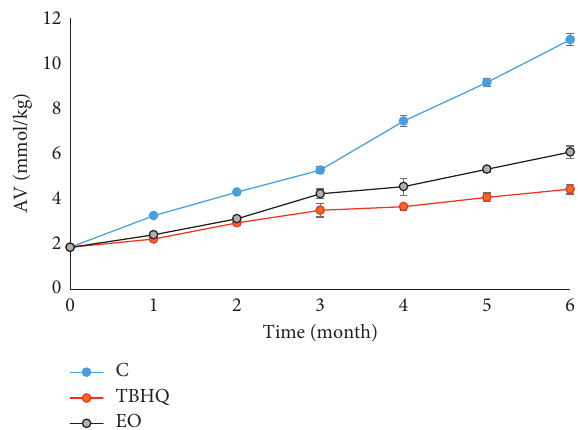
Figure 2: The thiobarbituric acid index (mg MDA/kg) in different treatments of mayonnaise during 6 months. EO: sample containing Z. multiflora essential oil; TBHQ: sample containing synthetic antioxidant TBHQ; C: control sample (control).